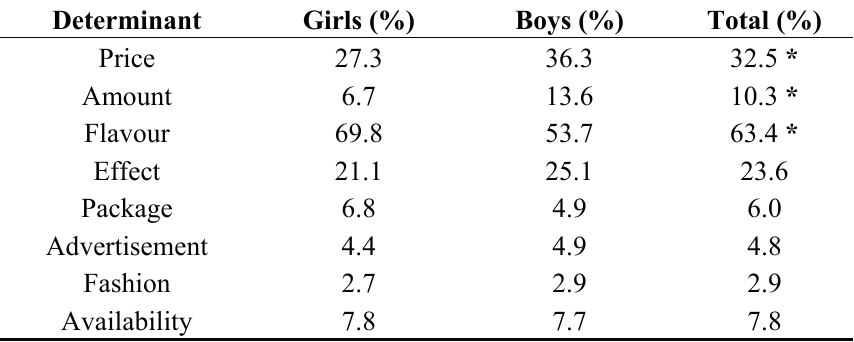
Table 2. Determinants influencing the purchase of energy drink.